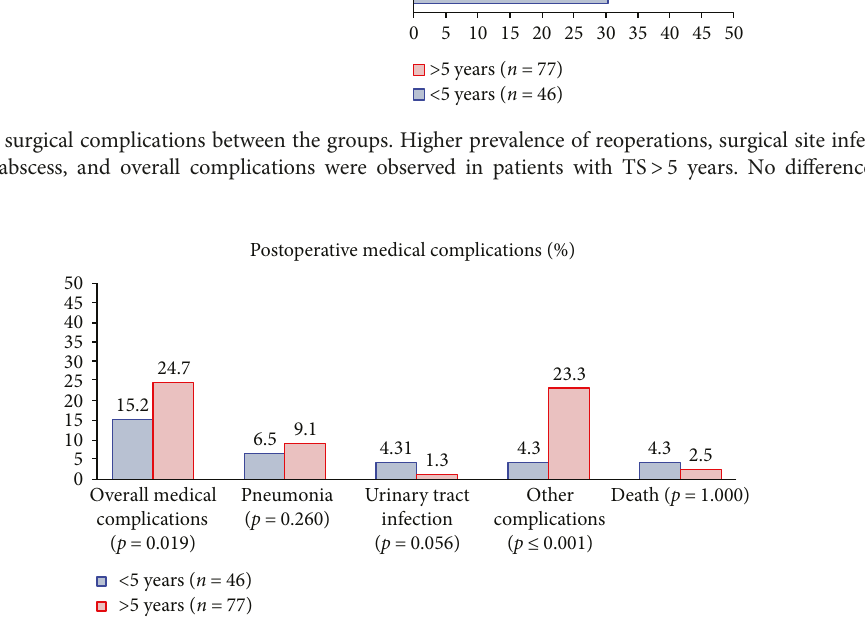
Figure 2: Postoperative medical complications between the groups. Overall complications and other complications were more prevalent in the TS > 5 years group. No statistical di ff erence was seen in pneumonia, urinary tract infection, or mortality between the groups. Table 2: Model of binary logistic regression analysis. Only the confection of stomas was identi fi ed as signi fi cant. Patients with TS > 5 years had higher risk of stomas with an odds ratio (OR) of